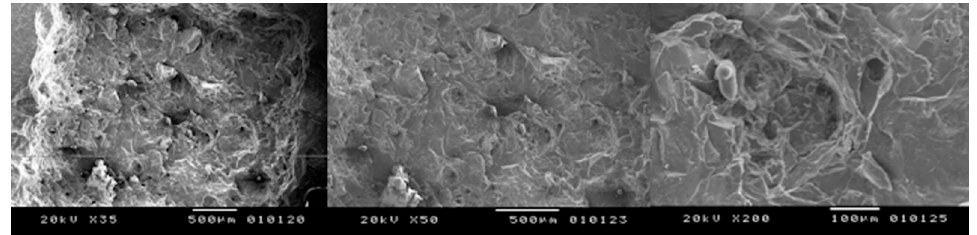
Figure 5. Peak power of 7.5 kW, speed of 50 mm/s: presence of melting and carbonization in some areas of the sample ( left ) X35; ( centre ) X50; ( right ) X200.